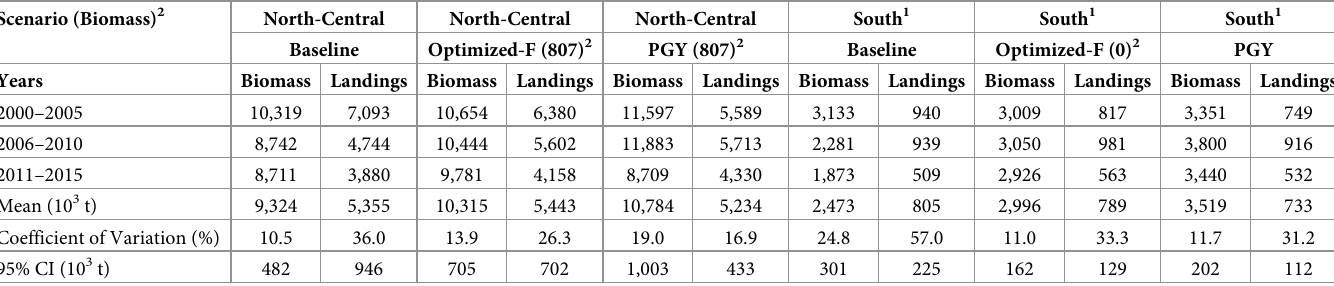
Table 2. Average biomass and landings outputs (10 3 t) of the scenario analysis for North-Central and Southern anchoveta stocks of Peru. Scenario (Biomass) 2